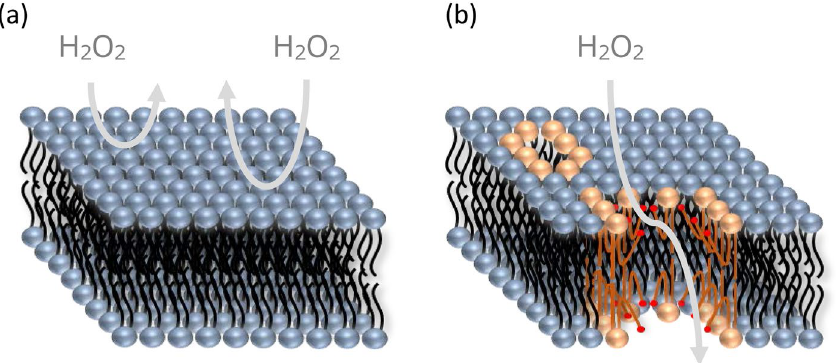
Figure 6. Schematic illustration of H 2 O 2 permeation through DOPC/PazePC bilayer. ( a ) DOPC bilayer without PazePC has high hydrophobic barrier at the alkyl chain region, which inhibits the permeation of H 2 O 2 . ( b ) PazePC undergoes self-assembly to form a hydrophilic pore that can act as a channel for hydrophilic H 2 O 2 .